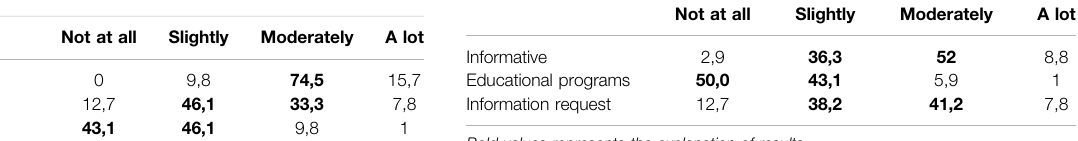
TABLE 2 | Frequencies obtained for the different types of intervention with students. Not at all